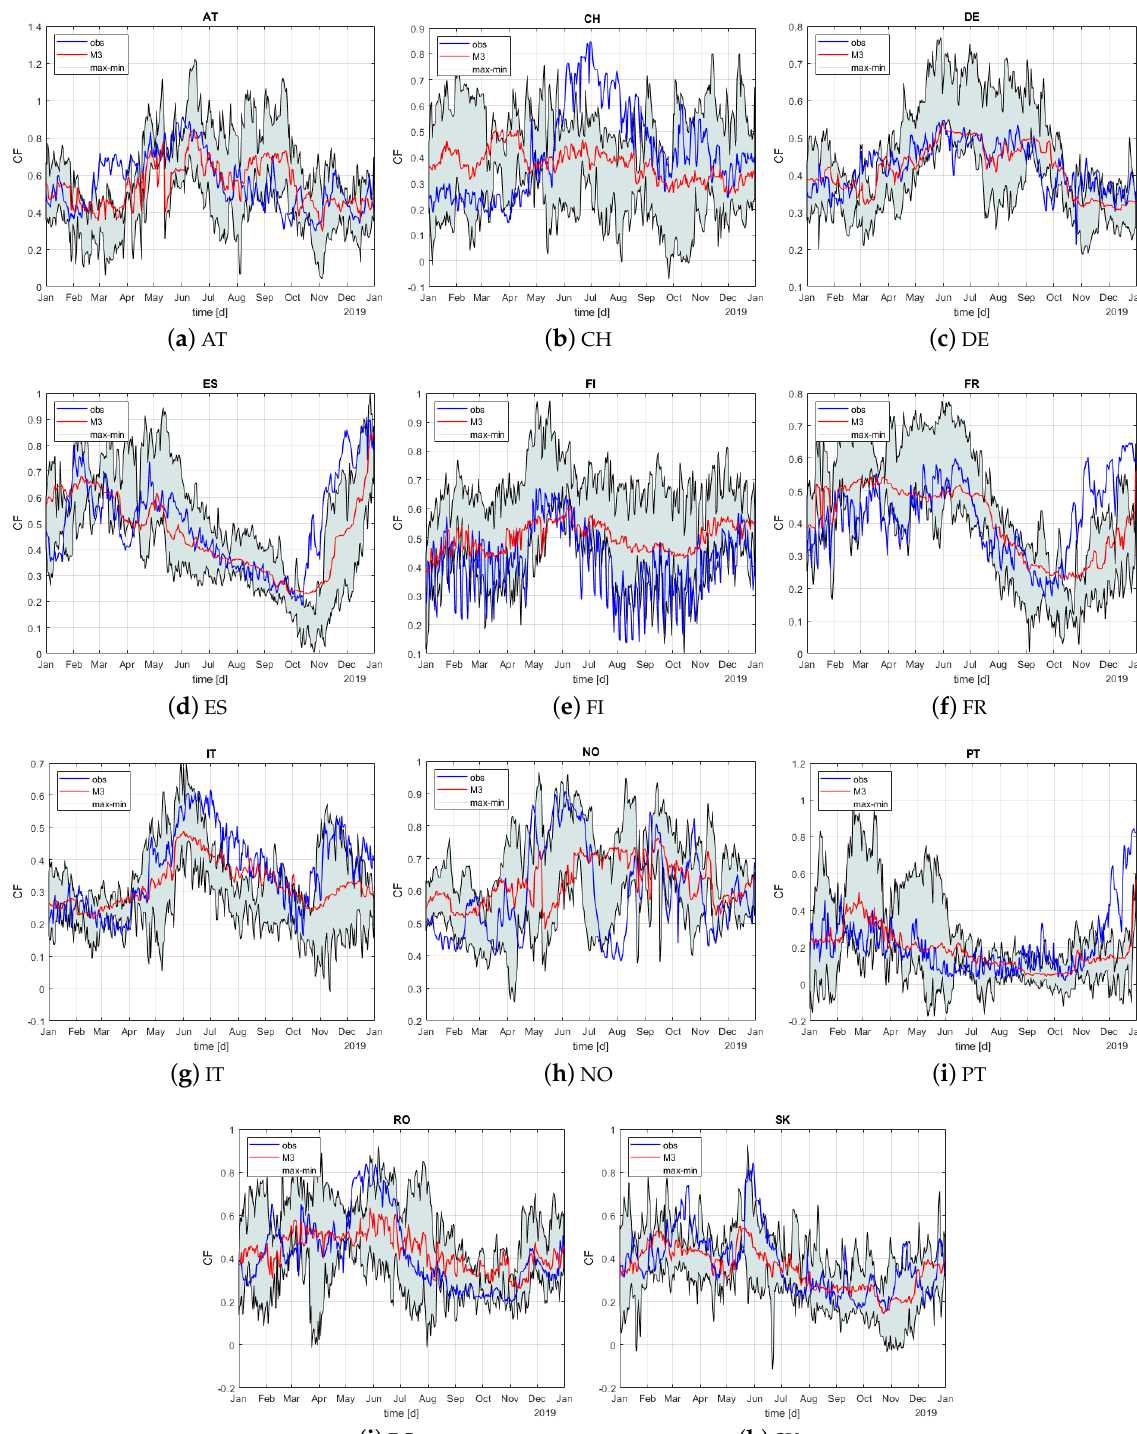
Figure 13. Observed capacity factor (blue line), M3 model prediction (red line), and maximum and minimum error envelops computed over the training set (black